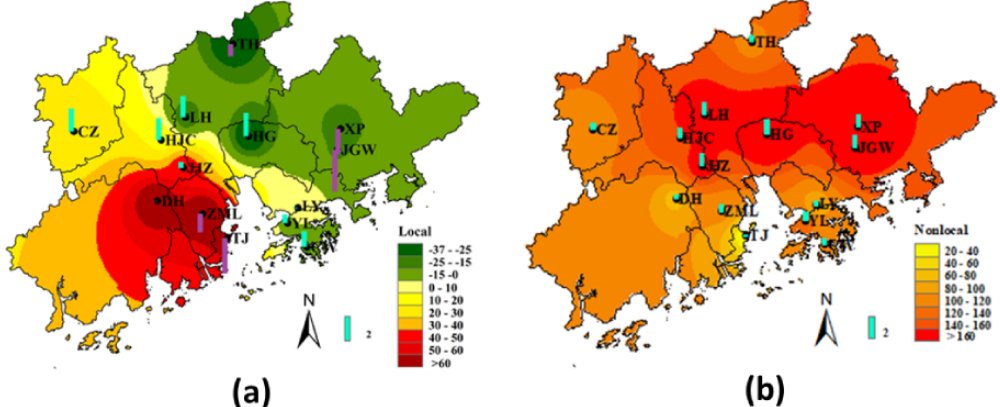
Figure 10. The spatial distribution of the ozone contribution from (a) local and (b) nonlocal emissions (µgm − 3 ) at each station and their annual rate of change in the Pearl River Delta during ozone episodes. Bars in blue (above) and in purple (below) the station point indicate the respective increasing and decreasing contribution trends. The bar length in the legend corresponds to an annual increase of 2µgm − 3 . Ozone contributions from local emissions are positive in the southwestern PRD and negative in the northeastern PRD. The central PRD is the only area with an increasing local ozone contribution trend. Ozone contributions from nonlocal emissions are positive and increasing region-wide.